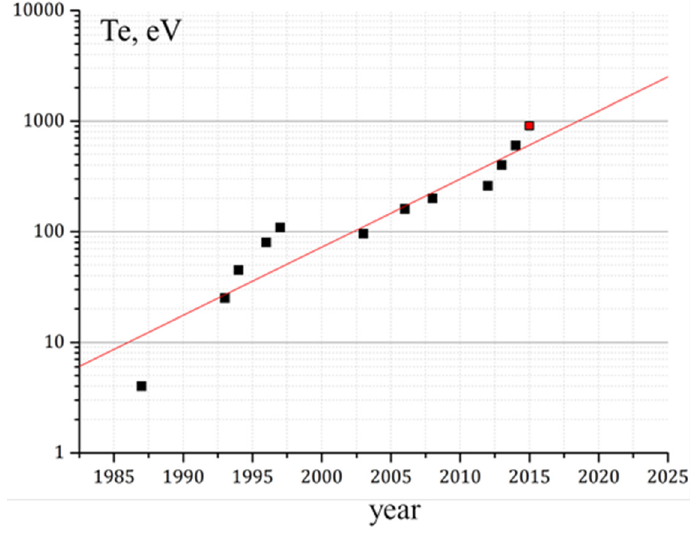
Figure 2. Electron temperature in GDT experiments vs. year of achievement. Red point is the achievement in year